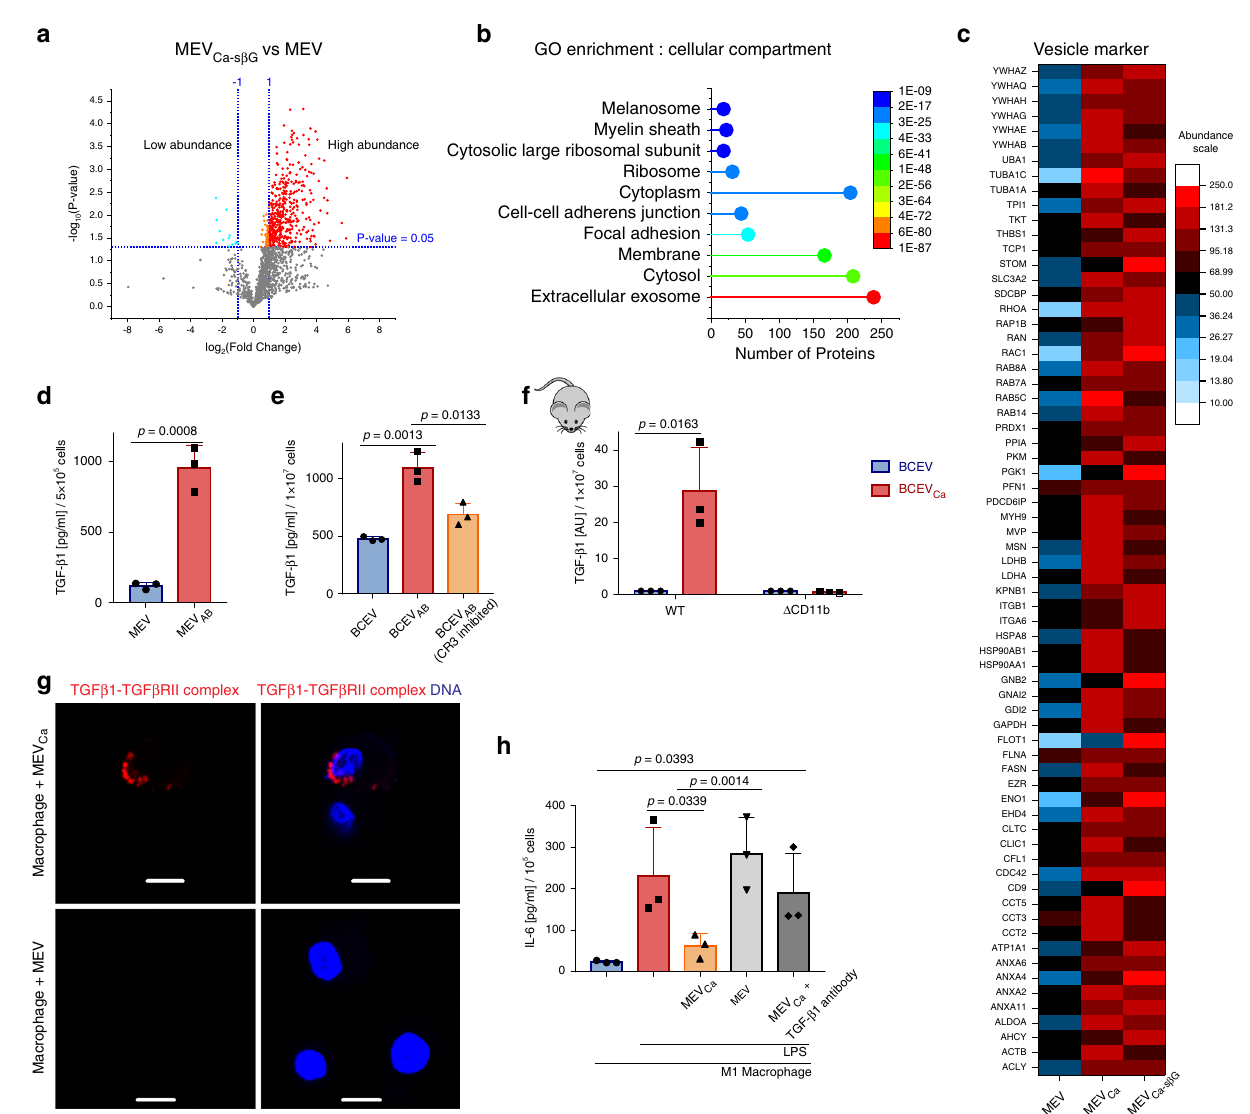
Fig. 5 MEV sCa downregulate IL-6 expression in human macrophages. a MEVs Ca-s β G show signi fi cantly increased protein concentrations compared with MEVs. MEVs and MEVs Ca-s β G were isolated from 1 × 10 7 monocytes, and proteins were detected using label-free LC-MS/MS-based proteomics ( p < 0.05, unpaired two-tailed t test, n = 3 different donors). b Most of the proteins in MEVs Ca-s β G are extracellular exosome-related as determined by GO enrichment analysis for cellular compartments. Comparison was performed between protein contents of MEVs Ca-s β G and MEVs from n = 3 donors. c MEVs Ca and MEVs Ca-s β G show upregulation of 68 vesicle marker proteins (ExoCarta) compared with MEVs. Protein contents of MEVs Ca and MEVs Ca-s β G were compared with that of MEVs from n = 3 donors. d TGF- β 1 increases in MEVs AB compared with MEVs. EVs were isolated after 1 h of co-incubated monocytes (5 × 10 5 ) with opsonized apoptotic bodies (data are presented as mean values + / − SD, p = 0.0008, unpaired two-tailed t test, n = 3 donors). e TGF- β 1 signi fi cantly increases in ex vivo blood cell-derived vesicles induced by apoptotic bodies (BCEVs AB ) compared with control blood cell-derived vesicles (BCEVs), but not when CR3 was blocked. Vesicles were isolated from 1 h co-incubated blood cells (1 × 10 7 ) (data are presented as mean values + / − SD, p = 0.0013, p = 0.0133, unpaired two-tailed t test, n = 3 donors). f TGF- β 1 signi fi cantly increases in ex vivo blood cell apoptotic body-induced vesicles (BCEVs AB ) compared to control blood cell-derived vesicles (BCEVs) in wild-type mice, but not in CD11b KO mice. In all cases, vesicles were isolated from 1 h induced blood cells (1 × 10 7 ) (data are presented as mean values + / − SD, p = 0.0163, unpaired two-tailed t test, n = 3 donors). g TGF- β 1 on MEVs Ca but not MEVs binds to TGF- β RII on macrophages by proximity ligation assay (PLA). Cells were incubated with EVs for 30 min, and PLA assay was performed to detect TGF- β 1/TGF- β RII complexes by CLSM. PLA staining – red: TGF- β 1/TGF- β RII complexes, blue: DNA. Bars: 10 µ m. A representative PLA of three experiments ( n = 3 donors) is shown. h IL-6 is induced in LPS-stimulated macrophages in the presence of MEVs, but not MEVs Ca. Blocking of TGF- β 1 on MEVs Ca did not reduce IL-6 production. M1 macrophages were differentiated from human blood monocytes, and IL-6 was measured by ELISA (data are presented as mean values + / − SD, p = 0.0339, p = 0.0014, p = 0.00393, unpaired two-tailed t test, n = 3 (Fig. 6c). When TGF- β 1 was labeled with immunogold, TGF- β 1- proteins were separated by SDS-PAGE and immunoblotted for transporting vesicles were observed, particularly on C. albicans markers of TGF- β 1 pathway activation, including phosphorylated hyphae (Fig. 6d). To determine the effect of TGF- β 1-containing SMAD2/3 and SMAD7. C. albicans infection resulted in strong vesicles in C. albicans infection, human whole blood was infected induction of SMAD2/3 phosphorylation (Fig. 6e). However, when with C. albicans for 4 h, and then blood cells were lysed, and TGF- β 1 was blocked during C. albicans whole blood infection with